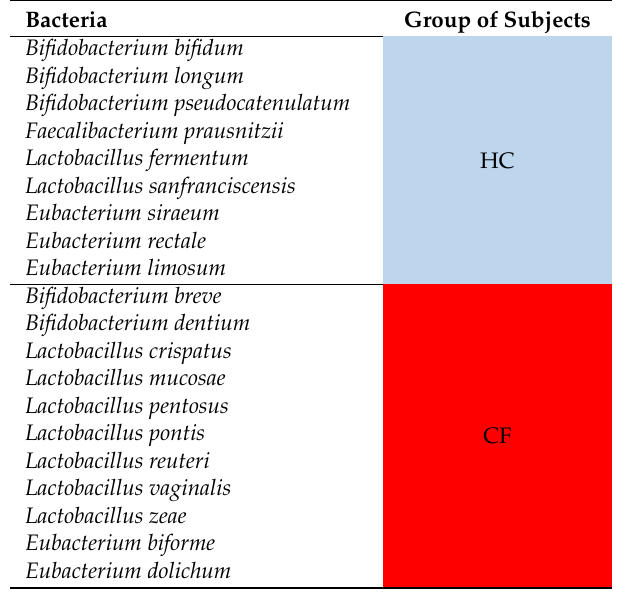
Figure 1. Histograms of the relative abundance of 24 selected operational taxonomic units (OTUs) in the gut microbiota (GM) patterns of cystic fibrosis (CF) patients and healthy controls (HC). These OTUs were chosen for their putative probiotic role. The histograms show the relative abundance of the searched putative probiotic bacteria scanned through the GM patterns of the CF patients and HC. ( Panel A ): 9 OTUs prevalently distributed in the GM profile of the CF subjects (relative abundance > 0.001); ( Panel B ): 11 OTUs prevalently distributed in the GM profile of the HC (relative abundance > 0.02). Fecalibacterium prausnitzii shows a statistically significant value False Discovery Rate (FDR) adjusted p value ≤ 0.1); ( Panel C ): 4 OTUs comparably distributed in the GM profiles of the CF patients and HC. Table 2. List of 20 bacteria prevalently associated with the GM profile of HC and CF patients. These OTUs were chosen for their putative probiotic role.